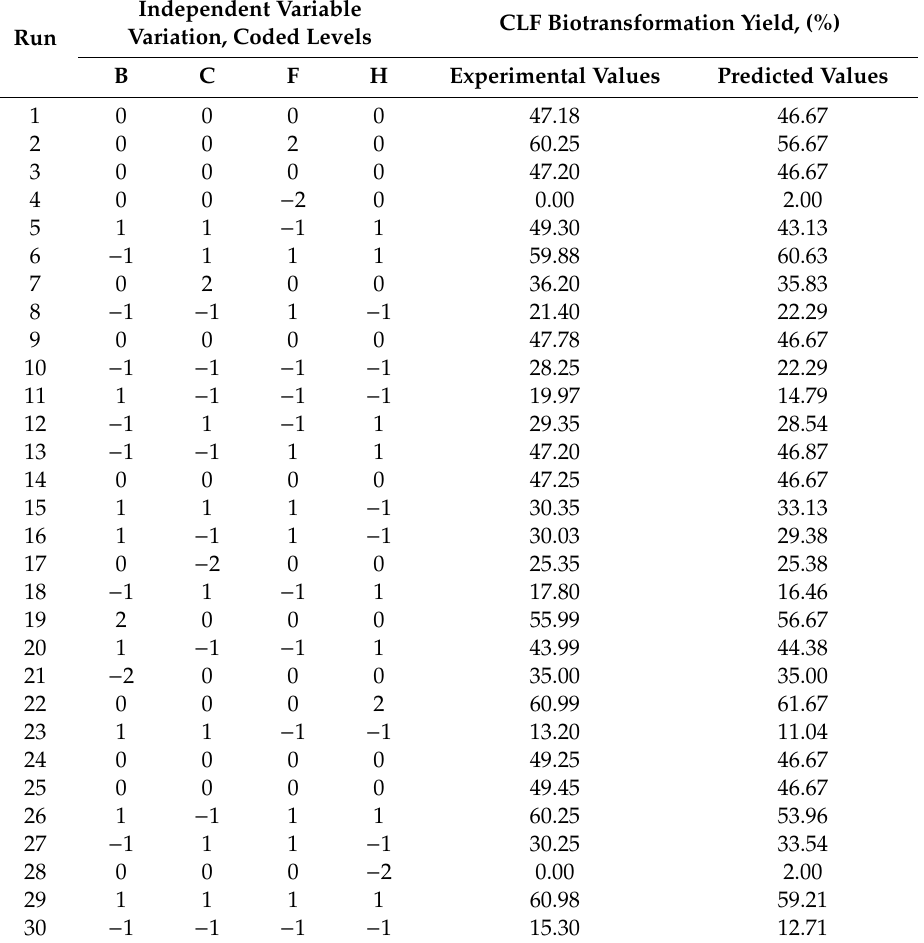
Table 4. Experimental design with experimental and predicted values of CLF biodegradation yield by Trametes pubescens